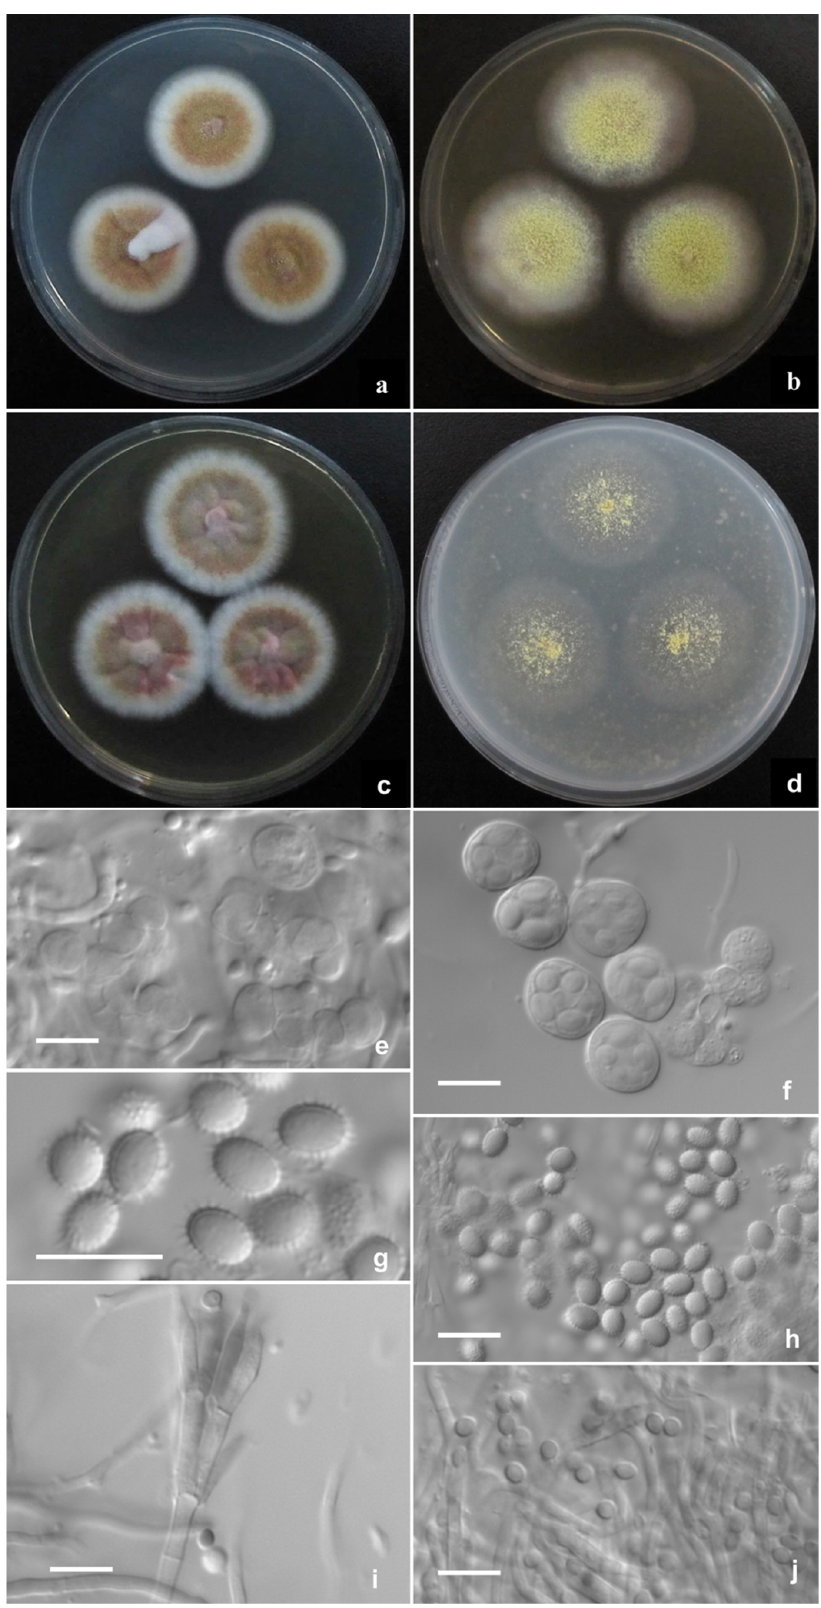
Figure 3. Talaromyces haitouensis AS3.16101 T incubated at 25 °C for 7 days. Colonies on ( a ) CYA. ( b ) MEA. ( c ) YES. ( d ) OA. ( e ) Initials. ( f ) Asci. ( g , h ) Ascospores. ( i ) Conidiophores. ( j ) Conidia. Scale Bars: 10 µm.